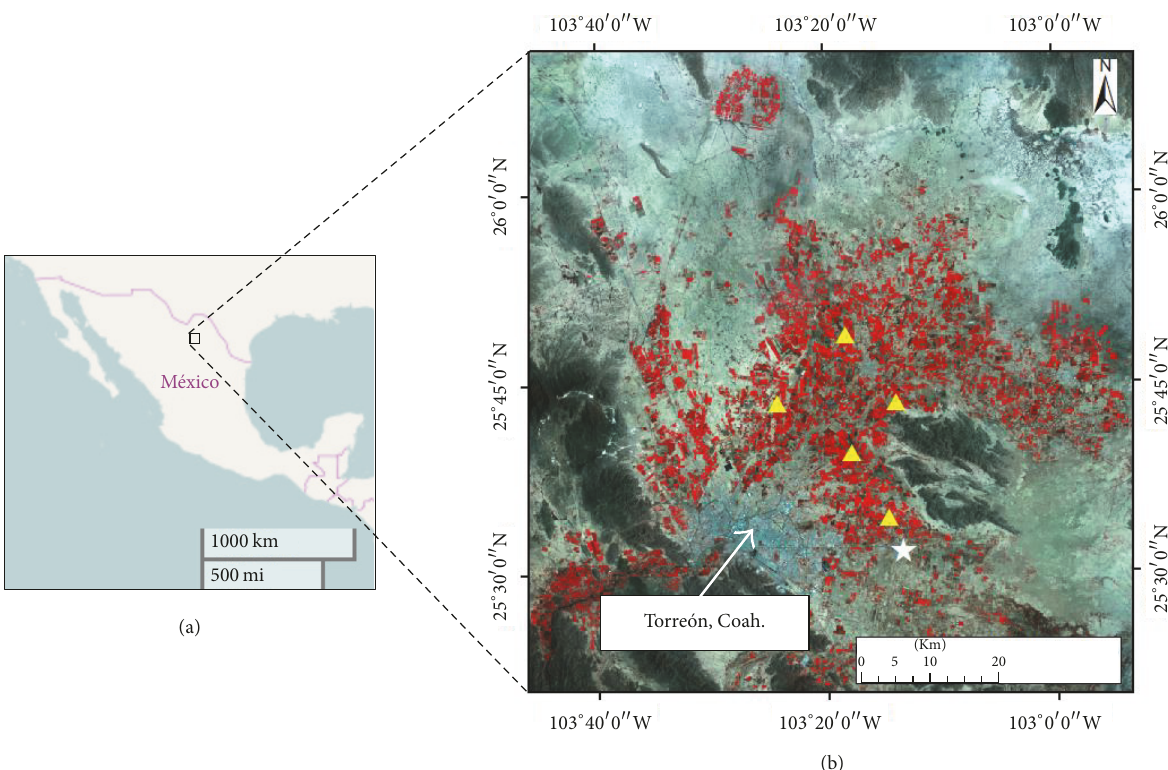
Figure 1: Location of the study area at northern Mexico (a). The subset of the area of interest, Landsat with false color composite (bands 4, 3, 2); the yellow triangles denote five locations where we selected the corn fields and the white star indicates weather station